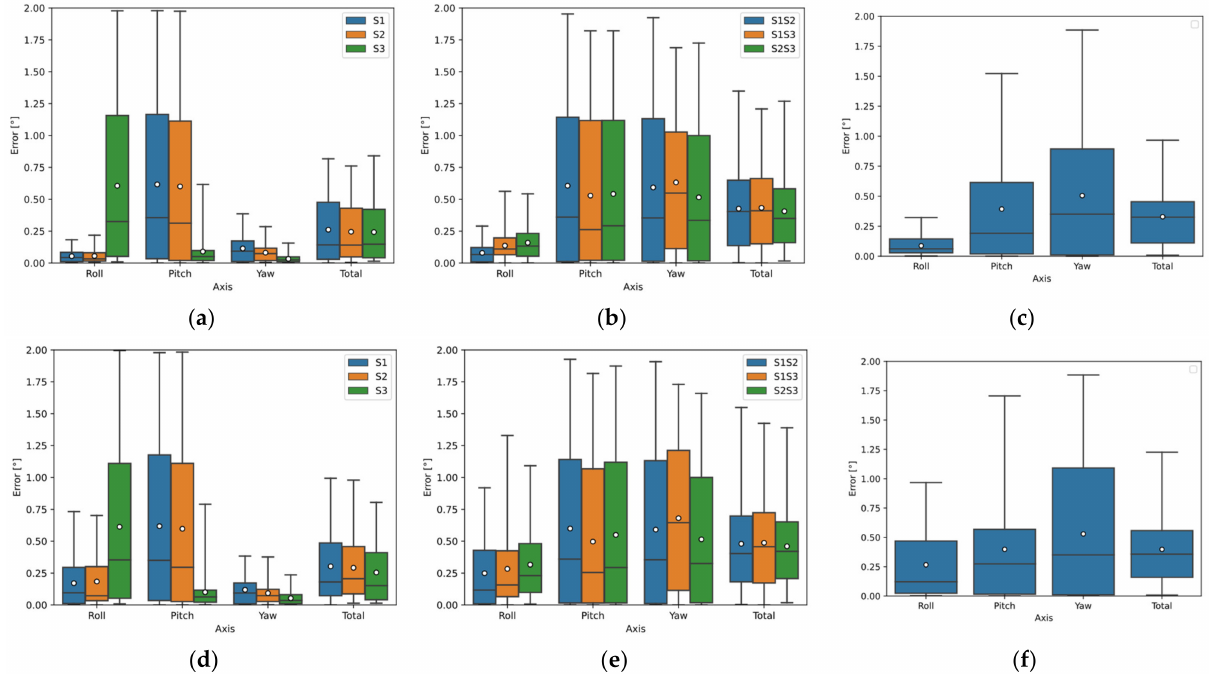
Figure 7. Object C orientation detection error by simulation using Open3D and PCL library: ( a ) sen- sors separately (Open3D); ( b ) two sensors configuration (Open3D); ( c ) three sensors configuration (Open3D); ( d ) sensors separately (PCL); ( e ) two sensors configuration (PCL); ( f ) three sensors config- uration